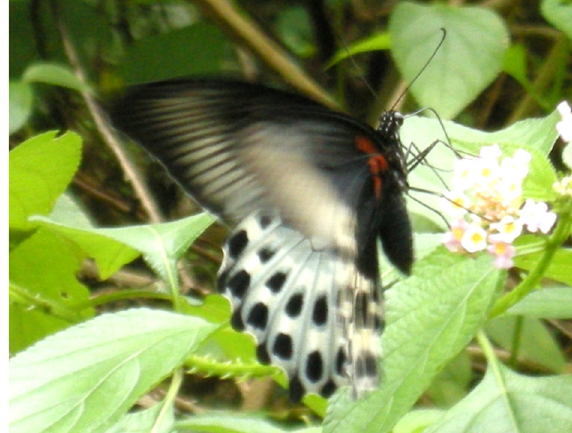
Image 2. Common Grass Yellow Eurema hecabe